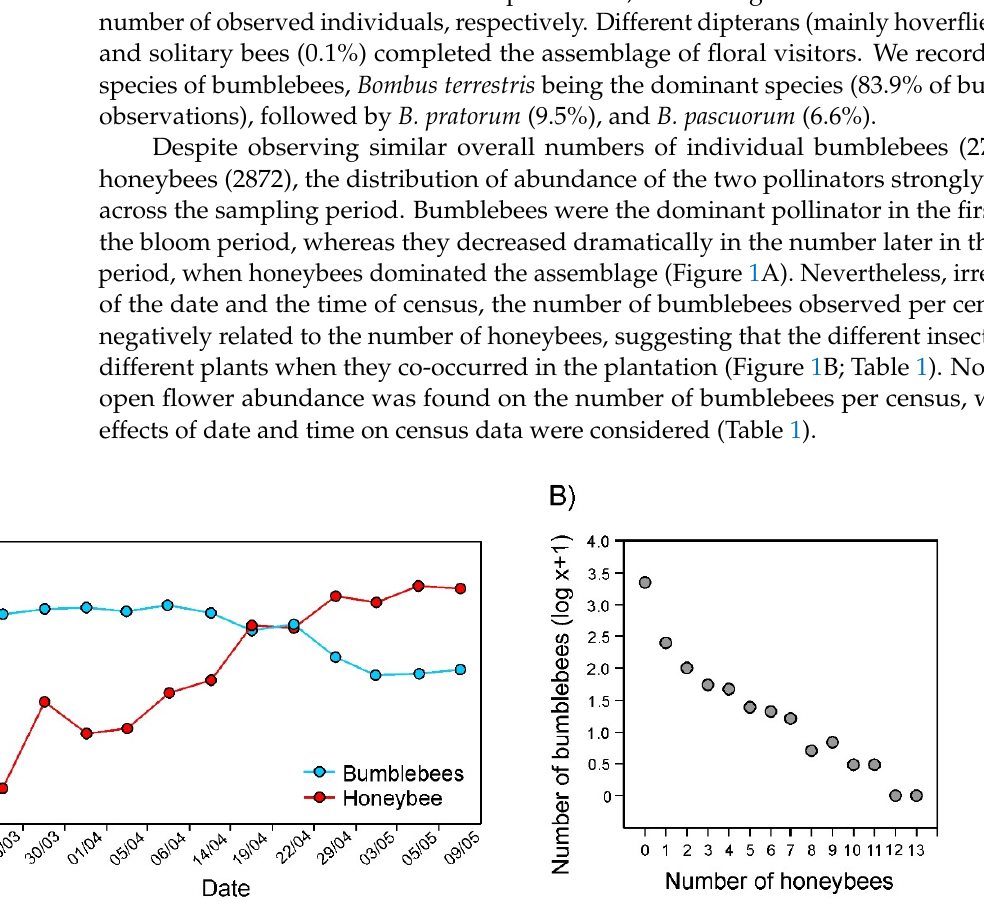
Figure 1. ( A ) Variation in the number of bumblebee ( Bombus spp.) and honeybee ( Apis mellifera ) individuals in censuses (data from different times and plants pooled) on different dates throughout the sampling period. ( B ) The cumulative number of bumblebee individuals observed in censuses with different numbers of honeybees observed (data from different dates pooled). Table 1. Generalized linear mixed model evaluating the effects of the number of honeybees, Apis